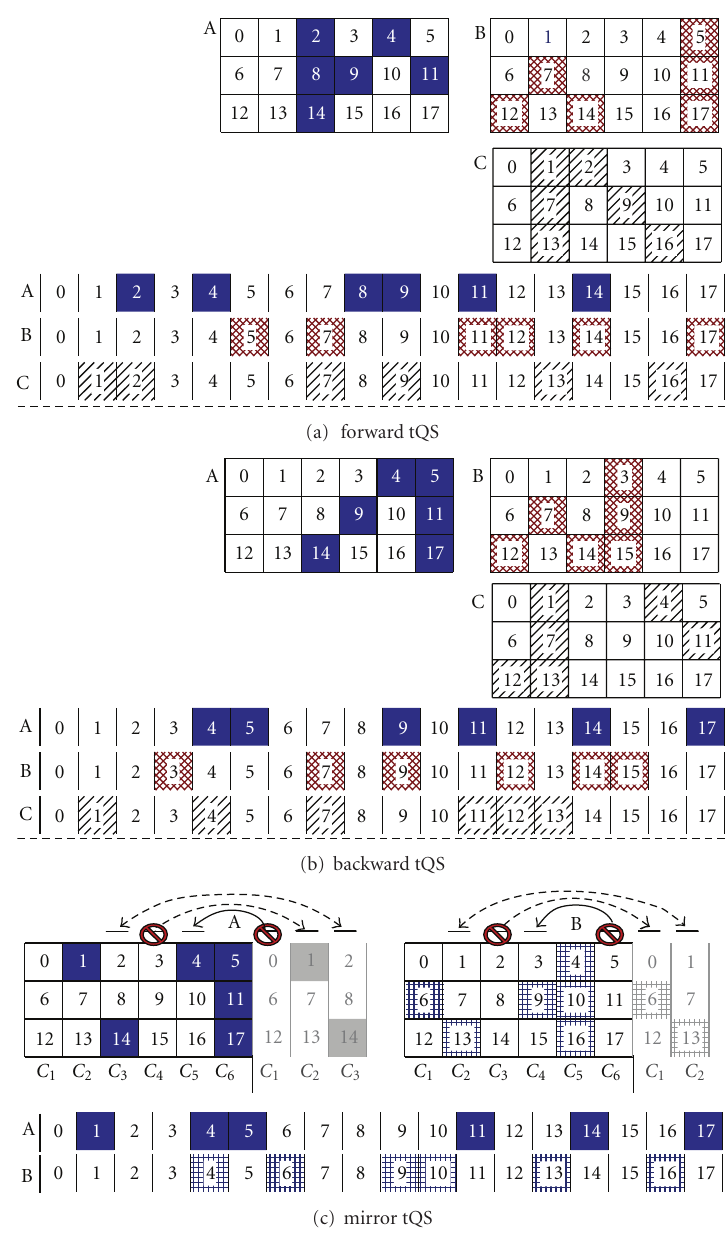
Figure 6: (a) Standard (forward), (b) backward, and (c) mirror tQS.